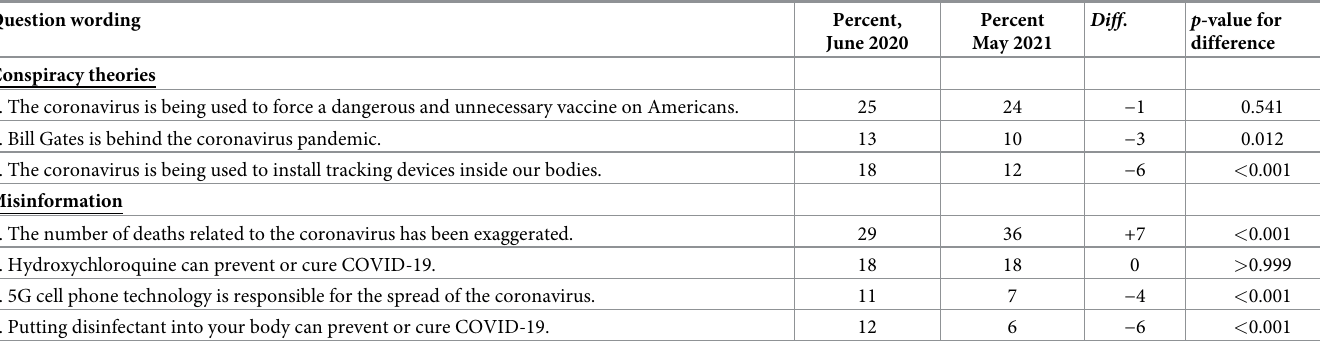
Table 1. Change in COVID-19 conspiracy beliefs and misinformation between June 2020 and May